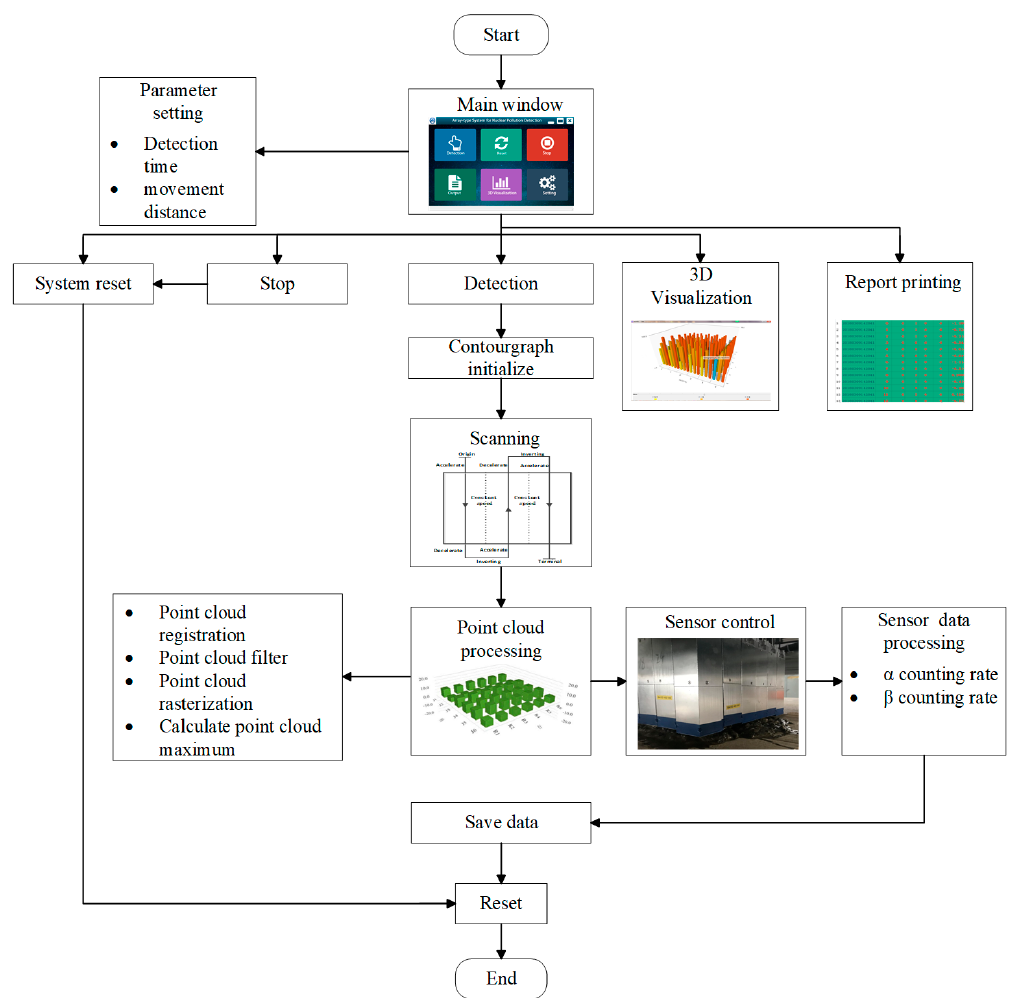
Figure 15. Flow chart of detection method for nuclear surface contamination.